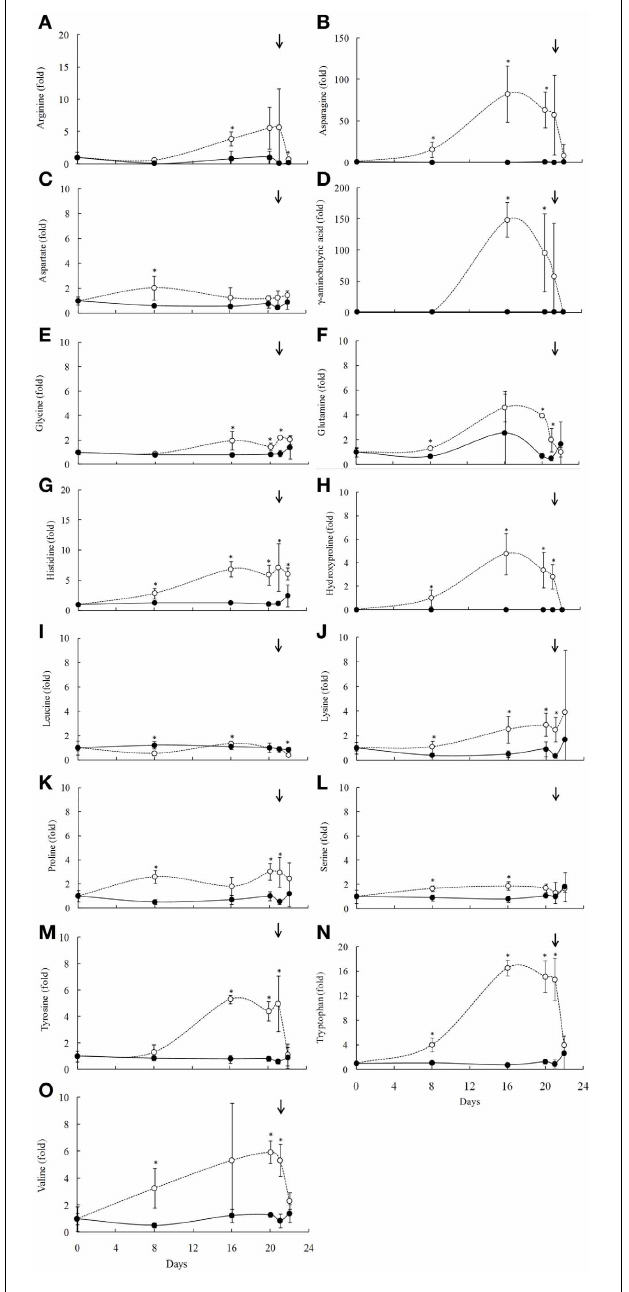
FIGURE 6 | Amino acids profile of the Barbacenia purpurea leaves during dehydration and rehydration (A–O). Relative proportion of the amino acids in leaves of daily watered plants (control group— • ) and plants under water suppression (treatment group— ◦ ) in summer season. The narrow indicates the day of rehydration. ∗ Significant difference between treatments at P < 0 . 05 ( n = 6 ± SD ). Data were normalized by the average of the values of Day 0 for each